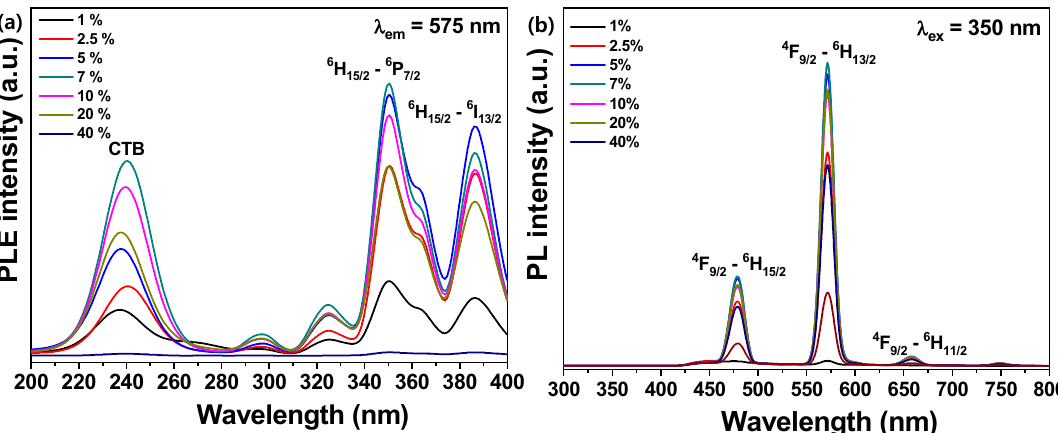
Figure 4. Photoluminescent properties of Dy 3+ -doped BaWO 4 phosphors with various concentrations of activator ions: ( a ) photoluminescence excitation, and ( b )